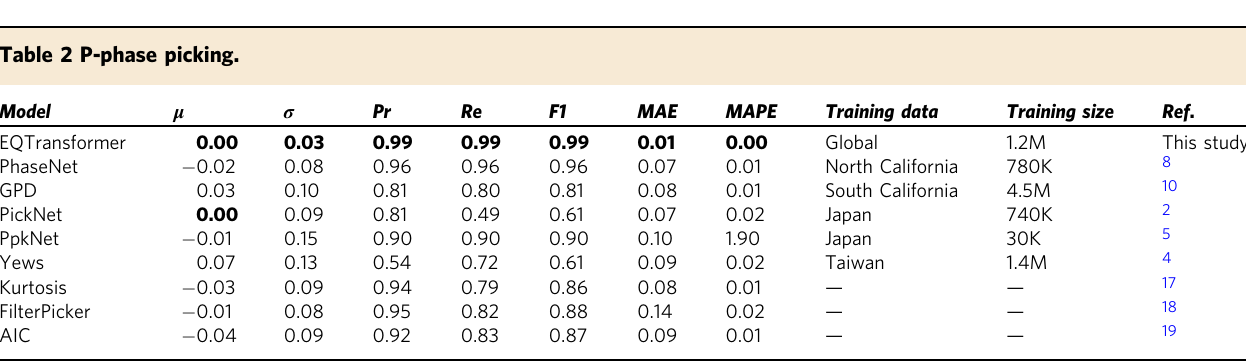
Table 2 P-phase picking.